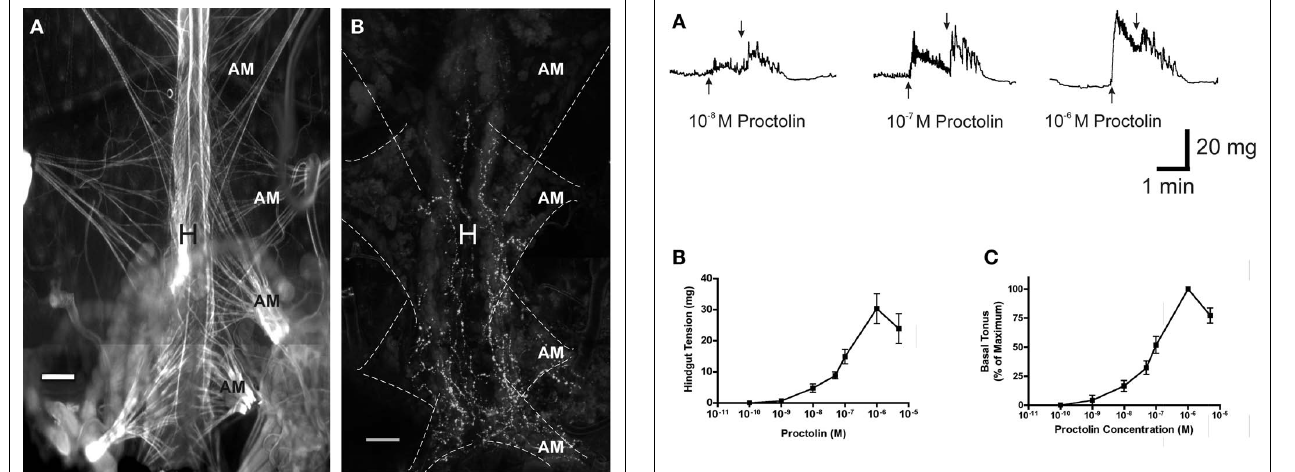
FIGURE 7 | Proctolin-like immunoreactivity is associated with the heart of fifth instar R. prolixus. (A) TRITC-labeled phalloidin staining for F-actin in muscle cells reveals pairs of alary muscles (AM) that anchor to the body wall, providing support and facilitating contractions of the heart (H). (B) Proctolin-like immunoreactive processes are associated with processes on the lateral margin of the heart and over the alary muscles.The alary muscles (AM) are outlined in hatched lines. All scale bars = 100 μ m, n = 10.